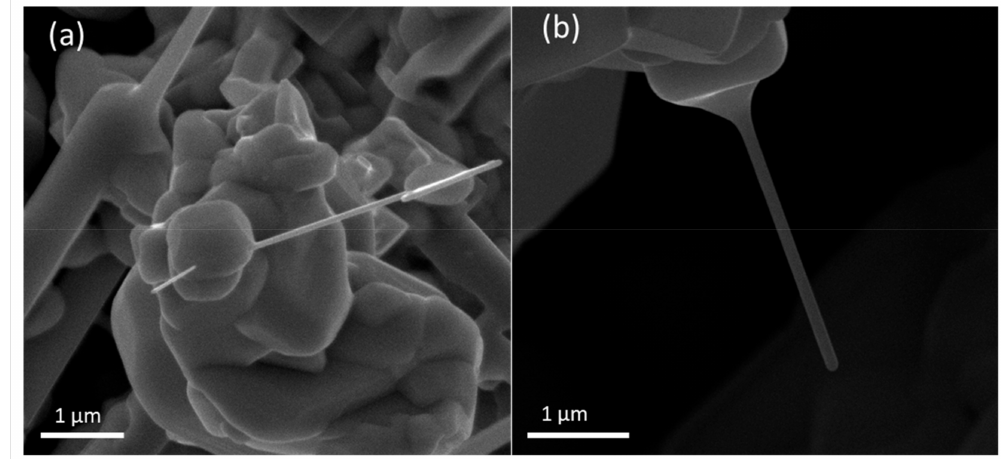
Figure 5. SEM image of SmB6 nanowire grown on ( a ) irregular particle and ( b ) cubic